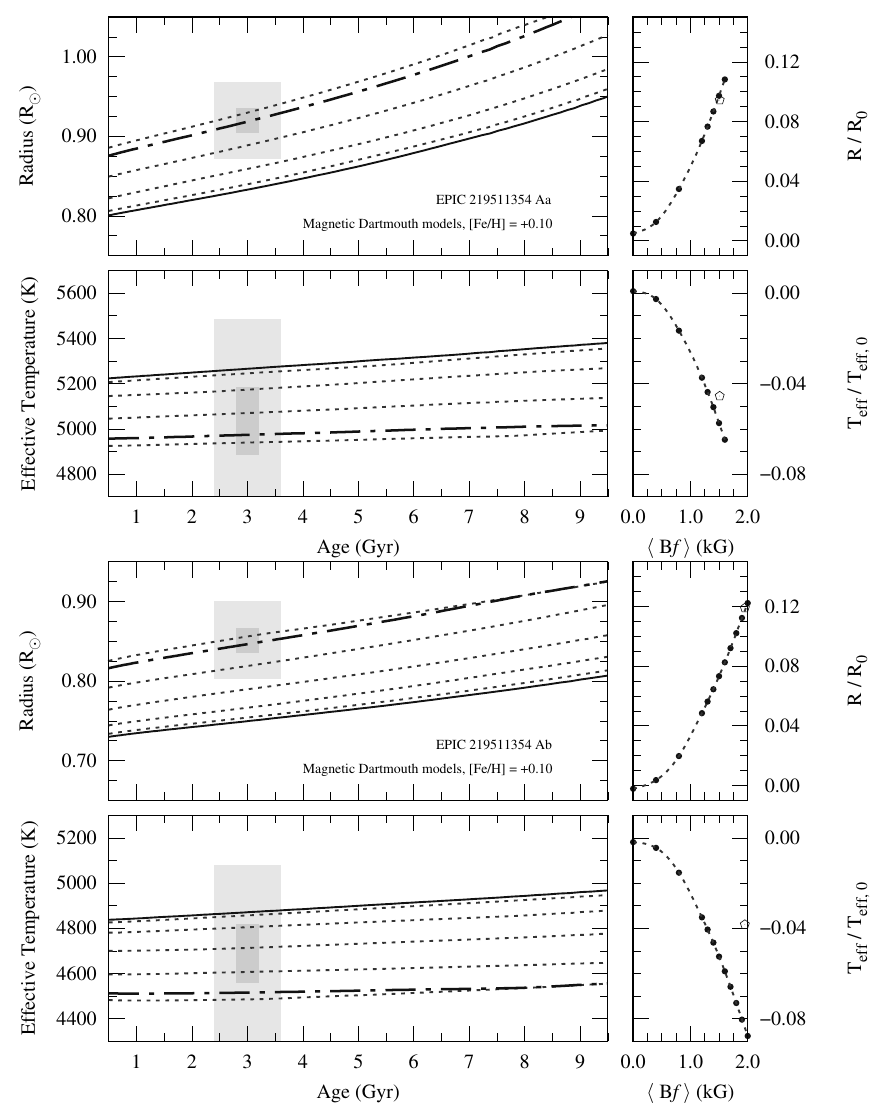
Figure 2. Estimating the average surface magnetic field strength for EPIC 219511354 Aa ( top panels ) and Ab ( bottom panels ). For each star, we plot the model radius and model T eff as a function of time for standard stellar evolution models from [25] (black lines), magnetic stellar evolution models Bf with in increments of 400 G (dotted lines), and best-fit magnetic stellar evolution model (dash- (cid:104) (cid:105) dotted lines). Gray shaded regions represent the 1 σ and 3 σ uncertainties surrounding the measured values. Side panels illustrate how the model radius and effective temperature change compared with Bf the standard model as a function of . Open symbols show the observed radius and effective (cid:104) (cid:105) Bf temperature deviations with the best-fit (cid:104) (cid:105)